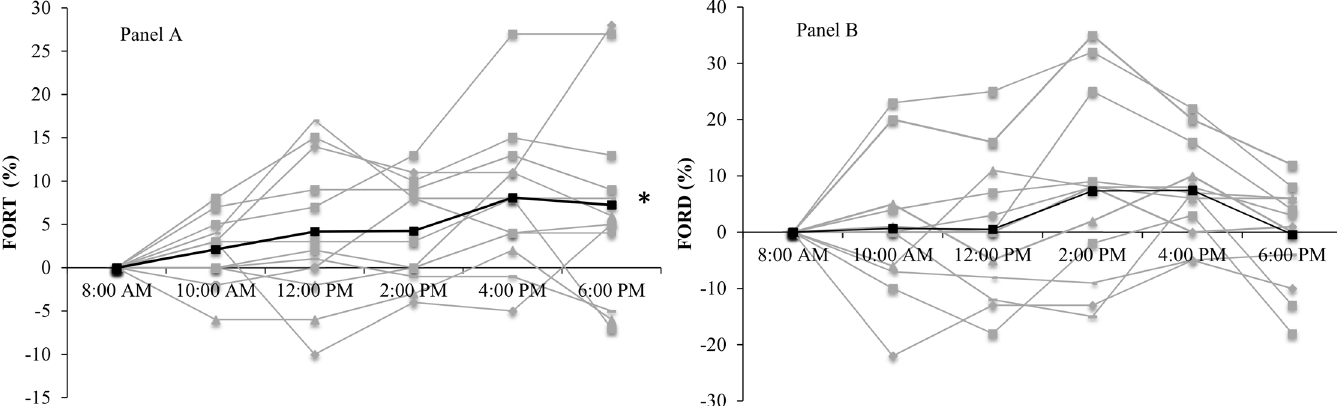
Fig 2. Relative changes (%) from baseline (time point 8:00 AM) for FORT (panel A) and FORD (panel B) over the 10-hours (n = 12). Dark black lines denote group average (mean) expressed as percentage change from baseline, with grey lines as individual responses. * Significant effect for FORT (panel A) over time (p <